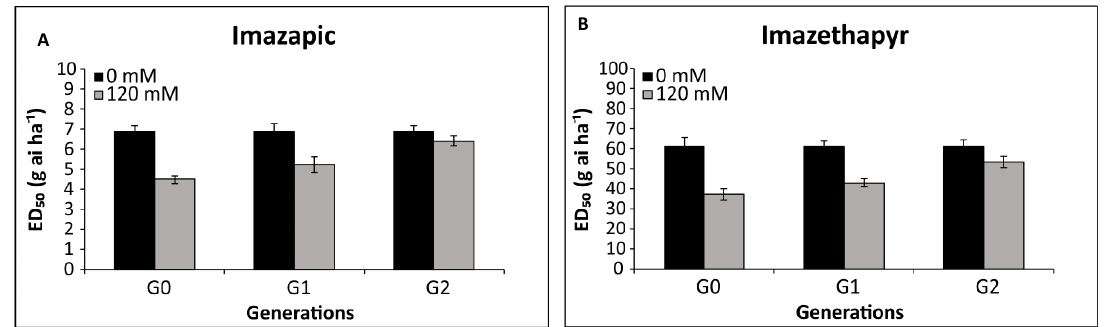
Figure 3. Results of ED 50 (herbicide efficacy) on Echinochloa colona as affected by cycles of recurrent exposure to salt stress and sublethal dose to the imidazolinones herbicides: application of a formulated mixture of imazapic + imazapyr (Kifix™) (A) and imazethapyr (B). Black and grey bars represent a salt concentration of 0 and 120 mM, respectively. Error bars indicate 95% confidence intervals.